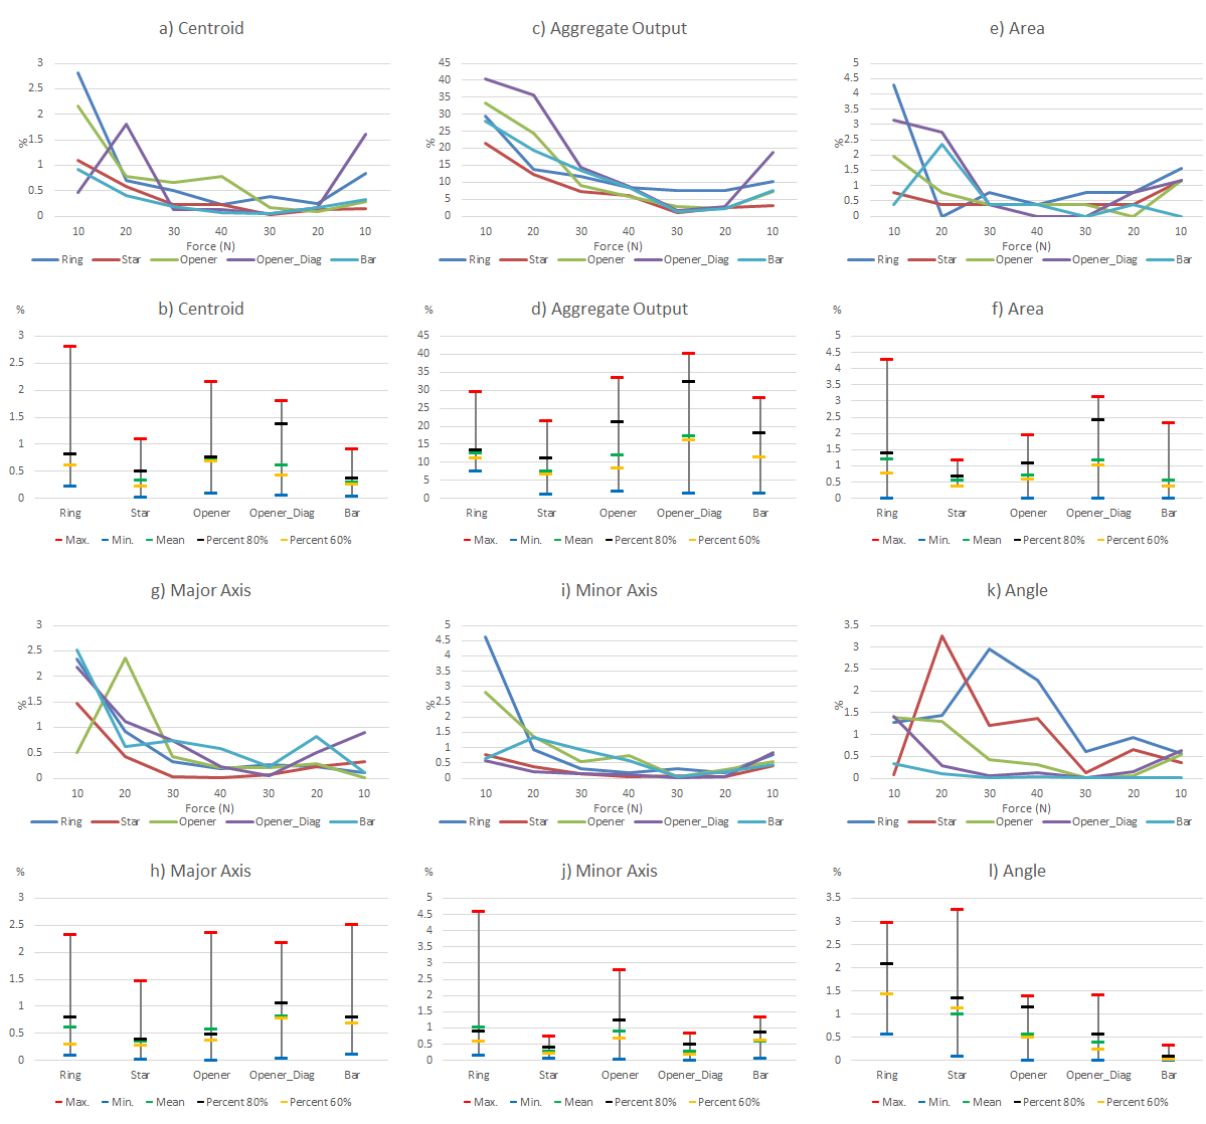
Figure 8. Variations of the system level parameters caused by the PCB based sensor drift.